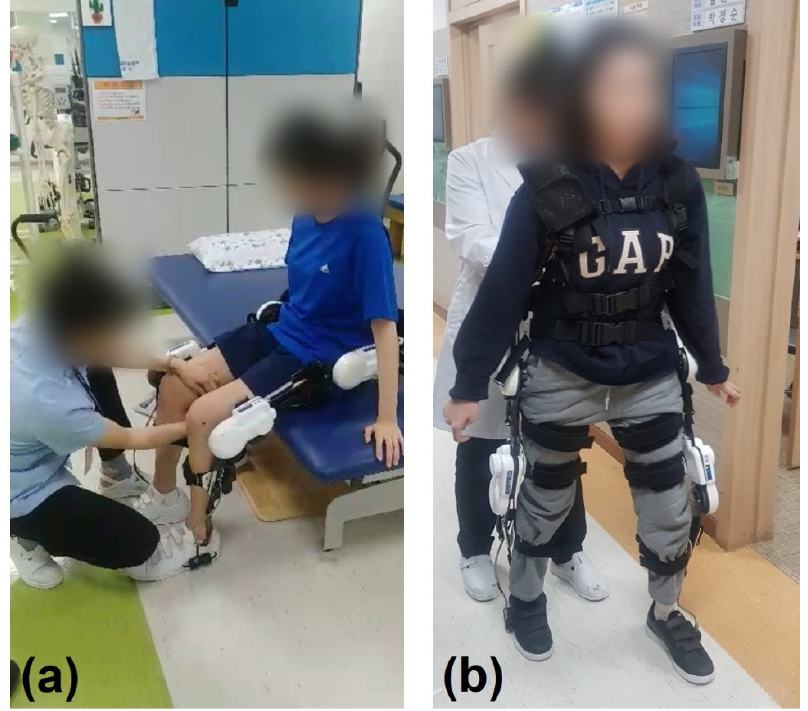
Figure 1. Robotic exoskeleton-assisted overground gait training. ( a ) Standing training wearing ANGELLEGS; ( b ) gait training wearing ANGELLEGS.